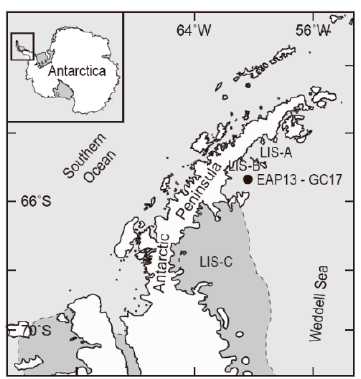
Figure 1. Location map of the EAP13-GC17 core (65°48.16’ S, 60°39.42’ W), Larsen ice shelf embayment, Weddell Sea, Antarctica.